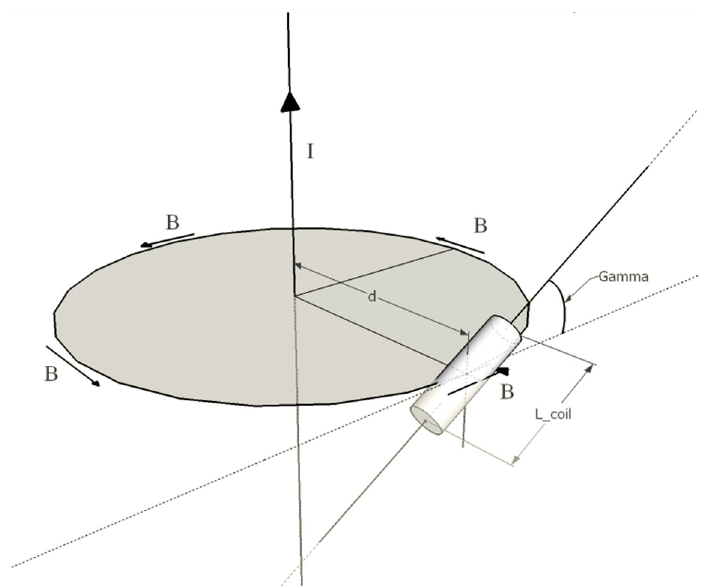
Figure 2. Magnetic coupling of an infinitely long current wire with a coil.